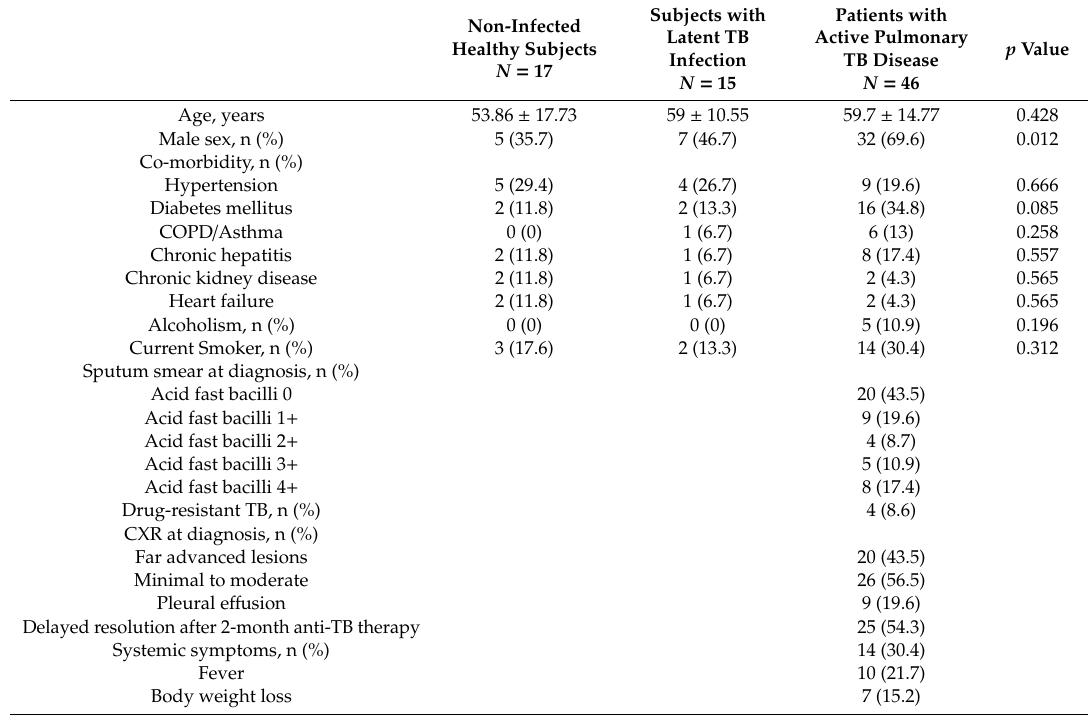
Table 1. Demographic, biochemistry, and clinical data of all the 78 study